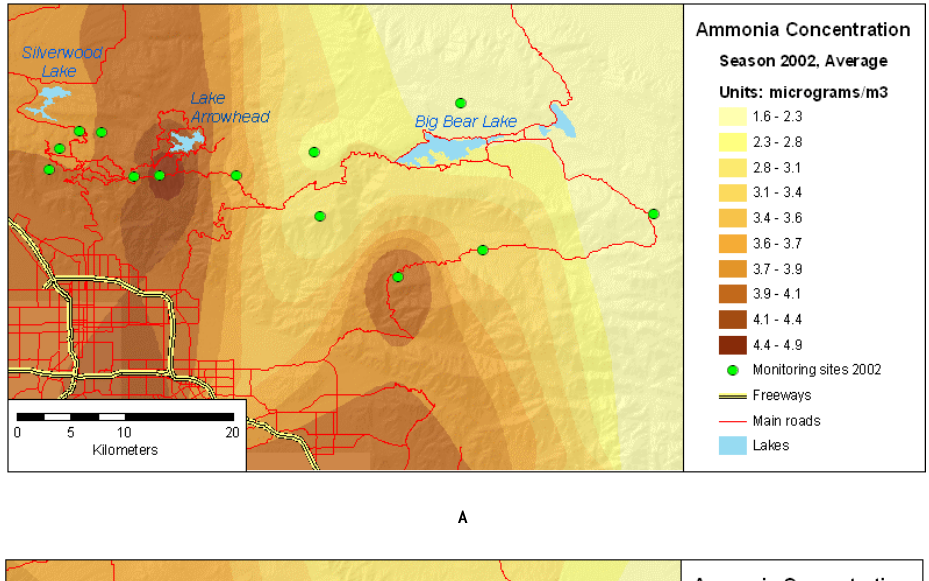
FIGURE 5. Distribution of NH 3 concentrations determined with passive samplers in the SBM; (A) 2002, (B) 2003, (C) 2004, and (D) 2005.